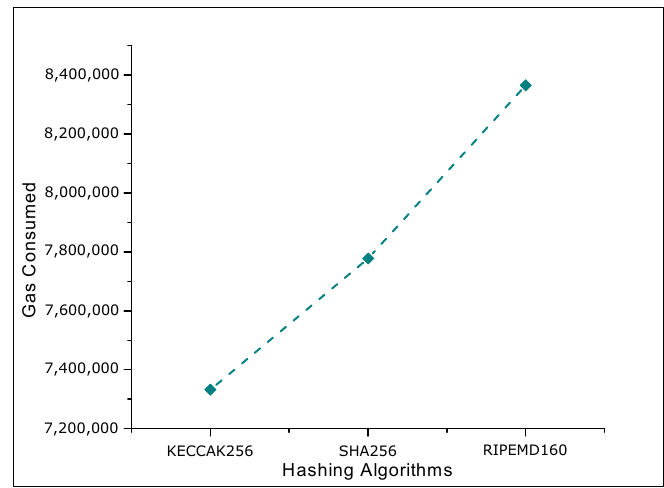
Figure 8. Comparison of Hashing